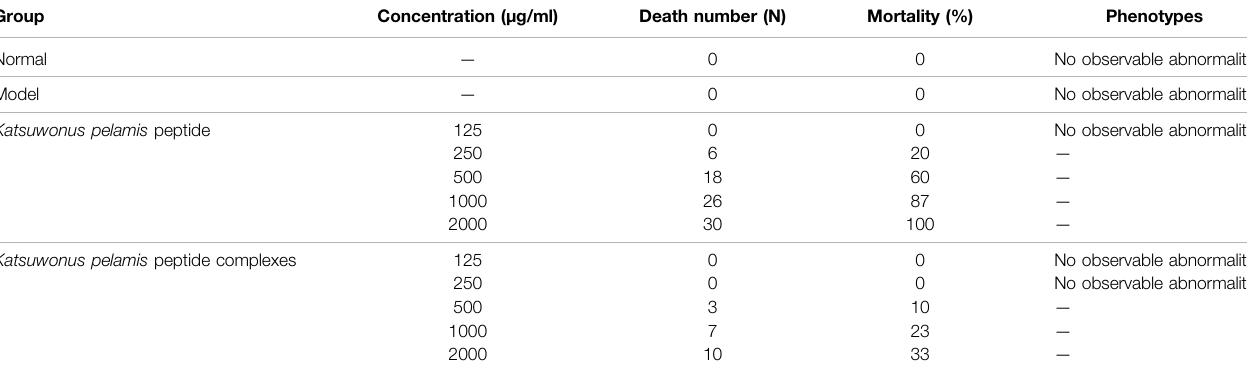
TABLE 1 | Death number and phenotypes in the zebra fi sh treated with Katsuwonus pelamis peptide and its complexes ( n = 30).